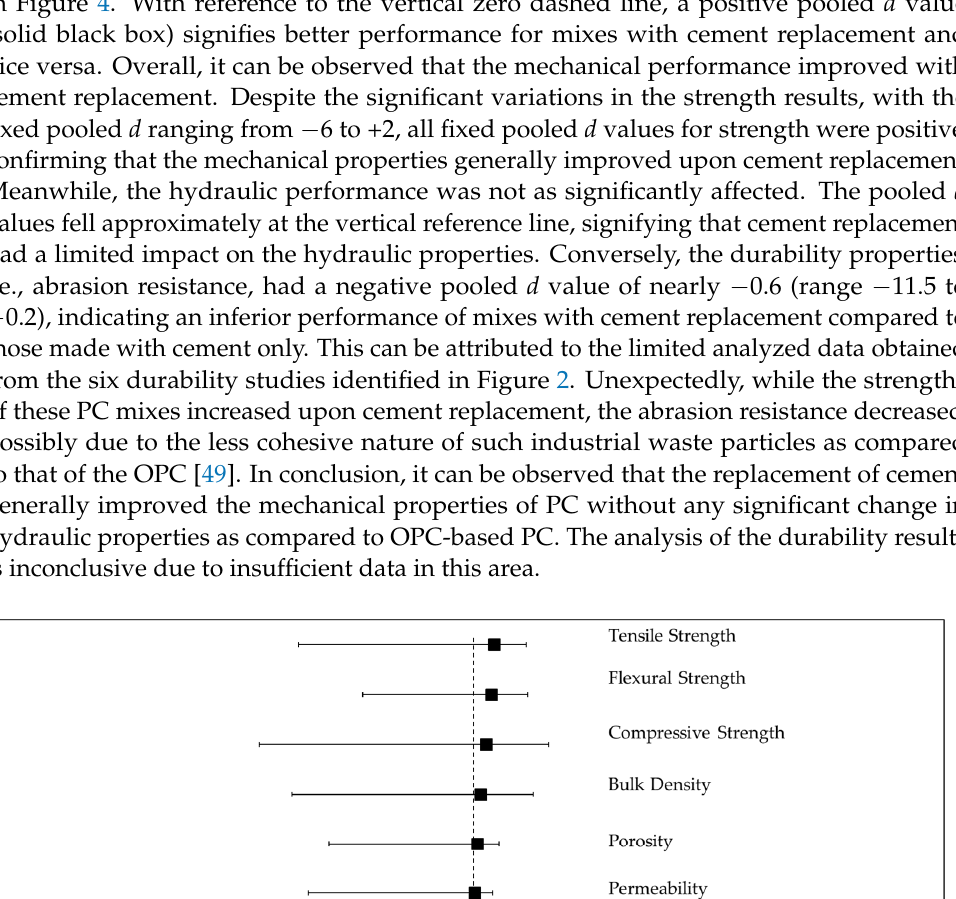
Figure 5. Mechanical and durability properties as a function of the cement replacement percentage.